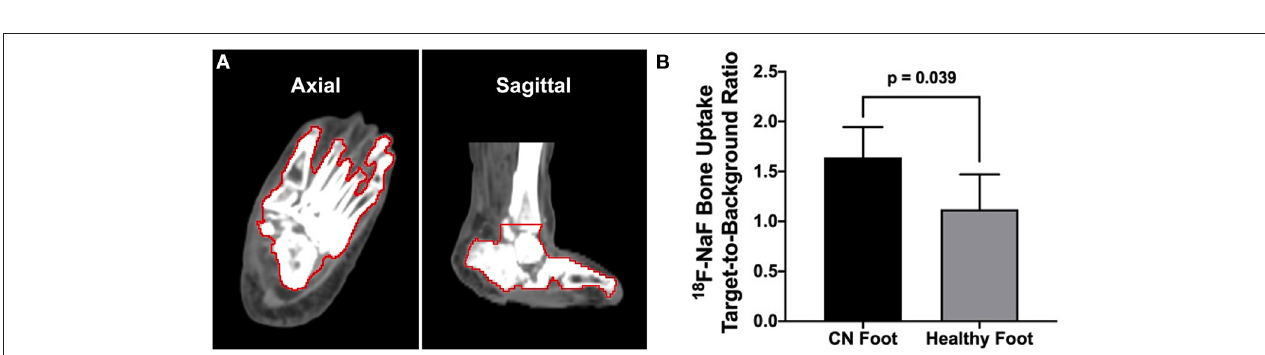
FIGURE 4 | CT image-guided segmentation of the bones of the foot and quantitative 18 F-NaF PET/CT image analysis. (A) Semiautomated segmentation of the bones of the foot and ankle (bone VOI outlined in red). (B) Quantitative analysis of PET/CT imaging demonstrated significantly higher bone uptake of 18 F-NaF in the CN foot compared to the healthy non-CN foot. N = three patients. Values represent means ± SD.